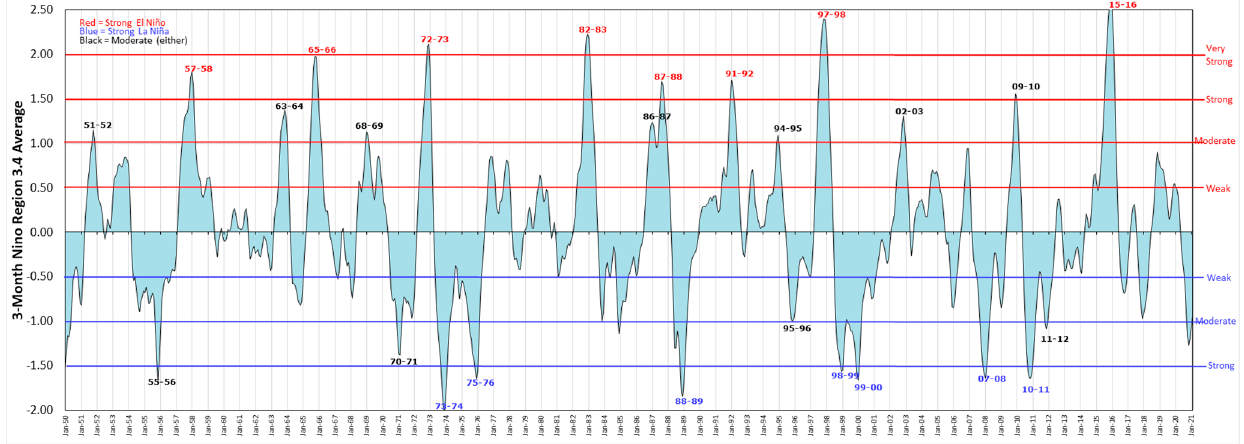
Figure 1. The Oceanic Niño Index (ONI) [16].